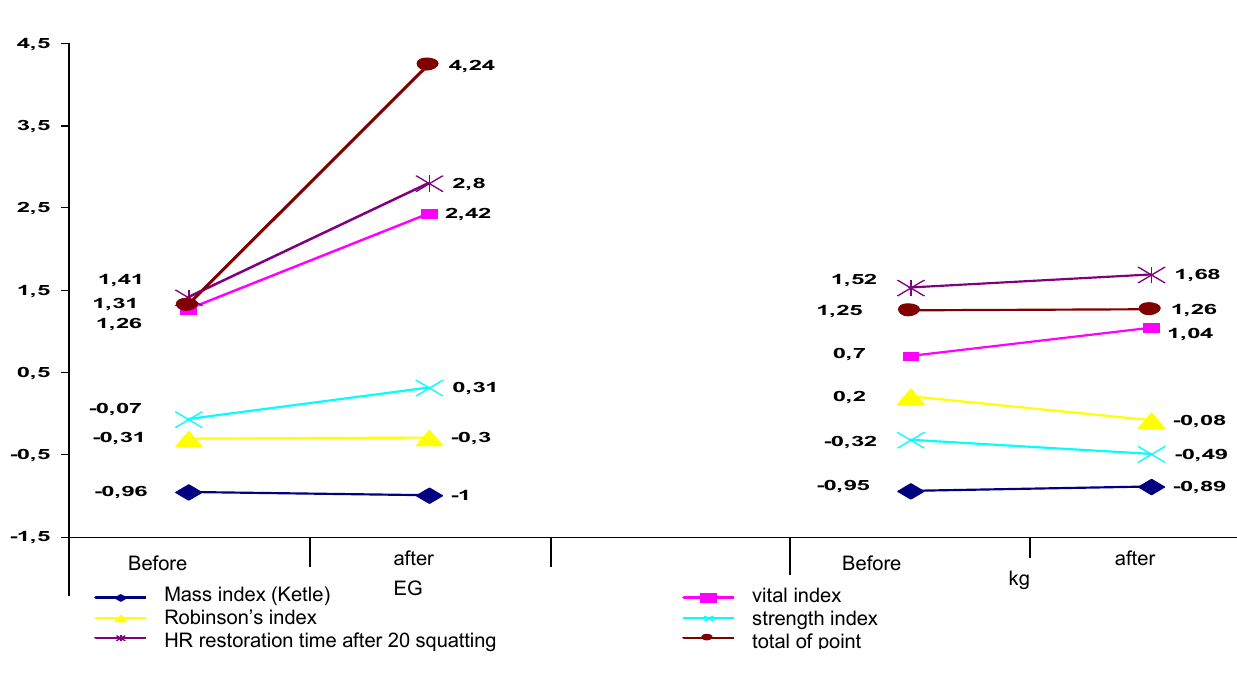
Fig.1. Somatic health level of EG and CG groups, determined by G.L.Apanasenko’s method before and after pedagogical experiment.